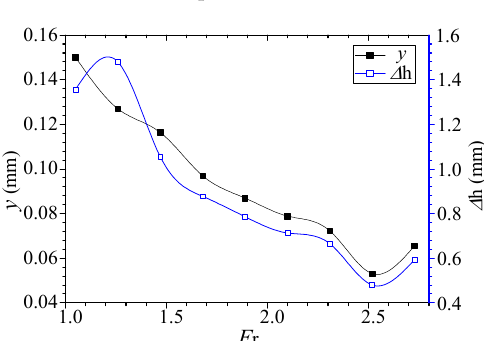
Figure 9. The height of the first layer grid ( y ) values and total thicknesses of the boundary layer grid at different speeds.